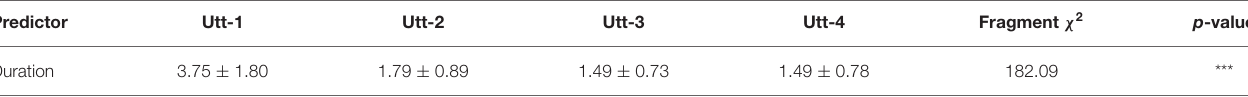
TABLE 8 | LMM on utterance duration in Fragment (Utt1-Utt4) fixed